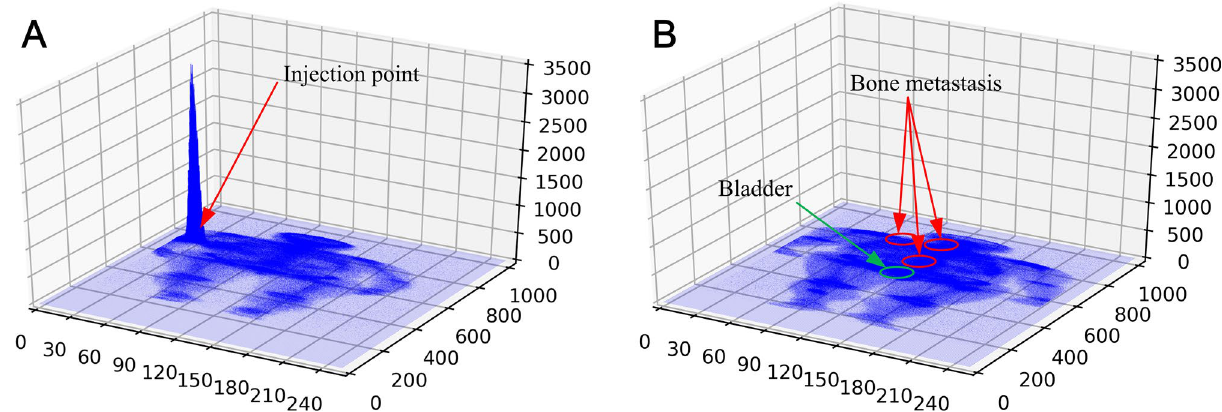
Figure 1. Distribution of radiation dosage in whole-body bone SPECT images. ( a ) Normal image with the concentrated injection point; and ( b ) image diagnosed with metastases marked by red polygons.